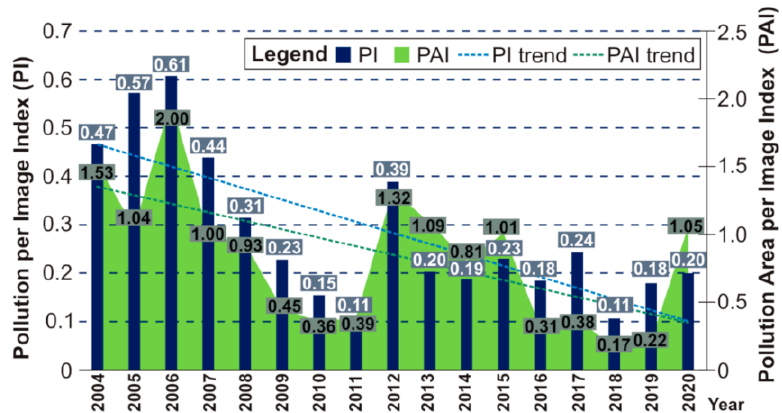
Figure 10. Interannual variability of the PI and PAI indices for